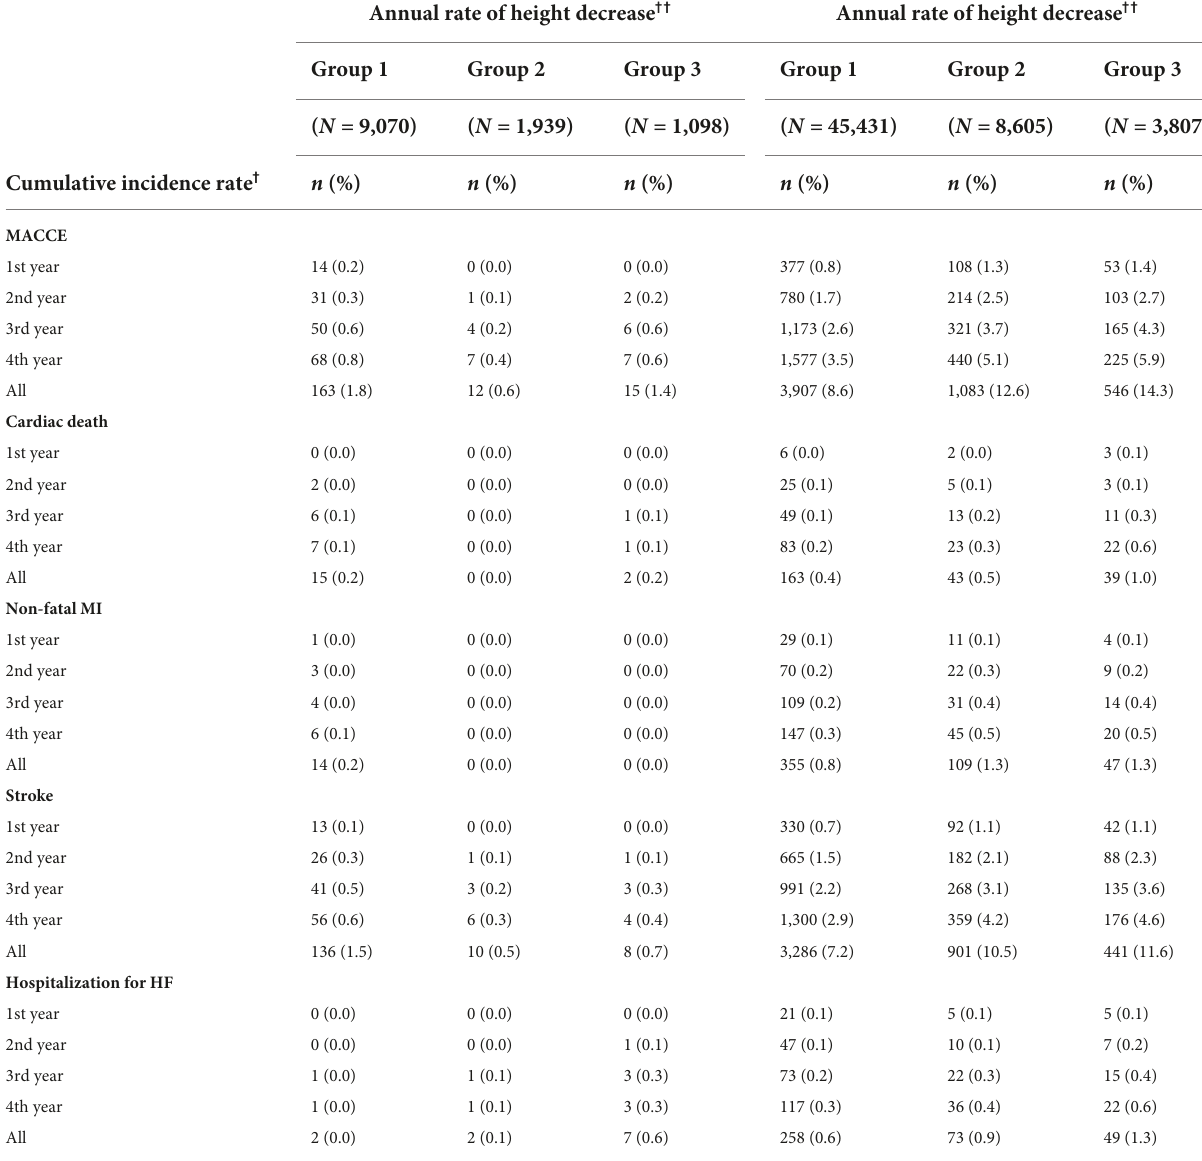
TABLE 6 The cumulative incidence rates of major adverse cardiovascular and cerebral events per the annual height decrease rate in female patients based on menopausal status.